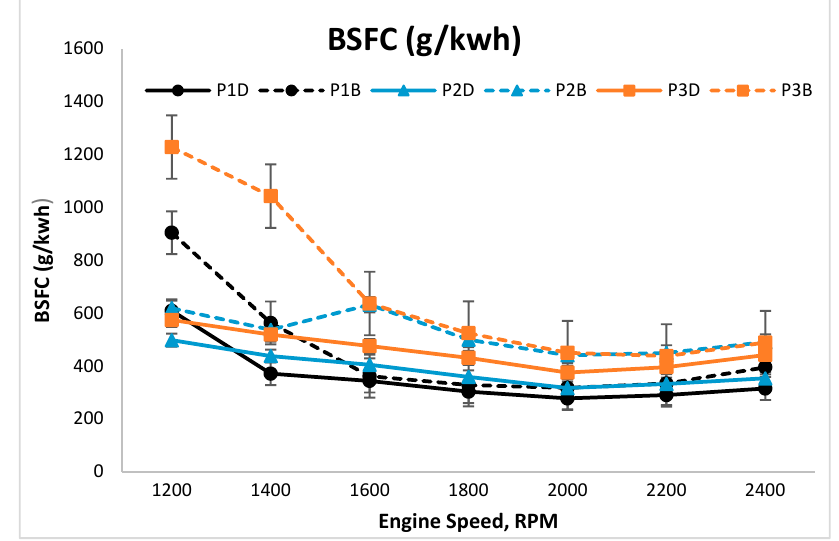
Figure 15. BSFC values at variable speeds.